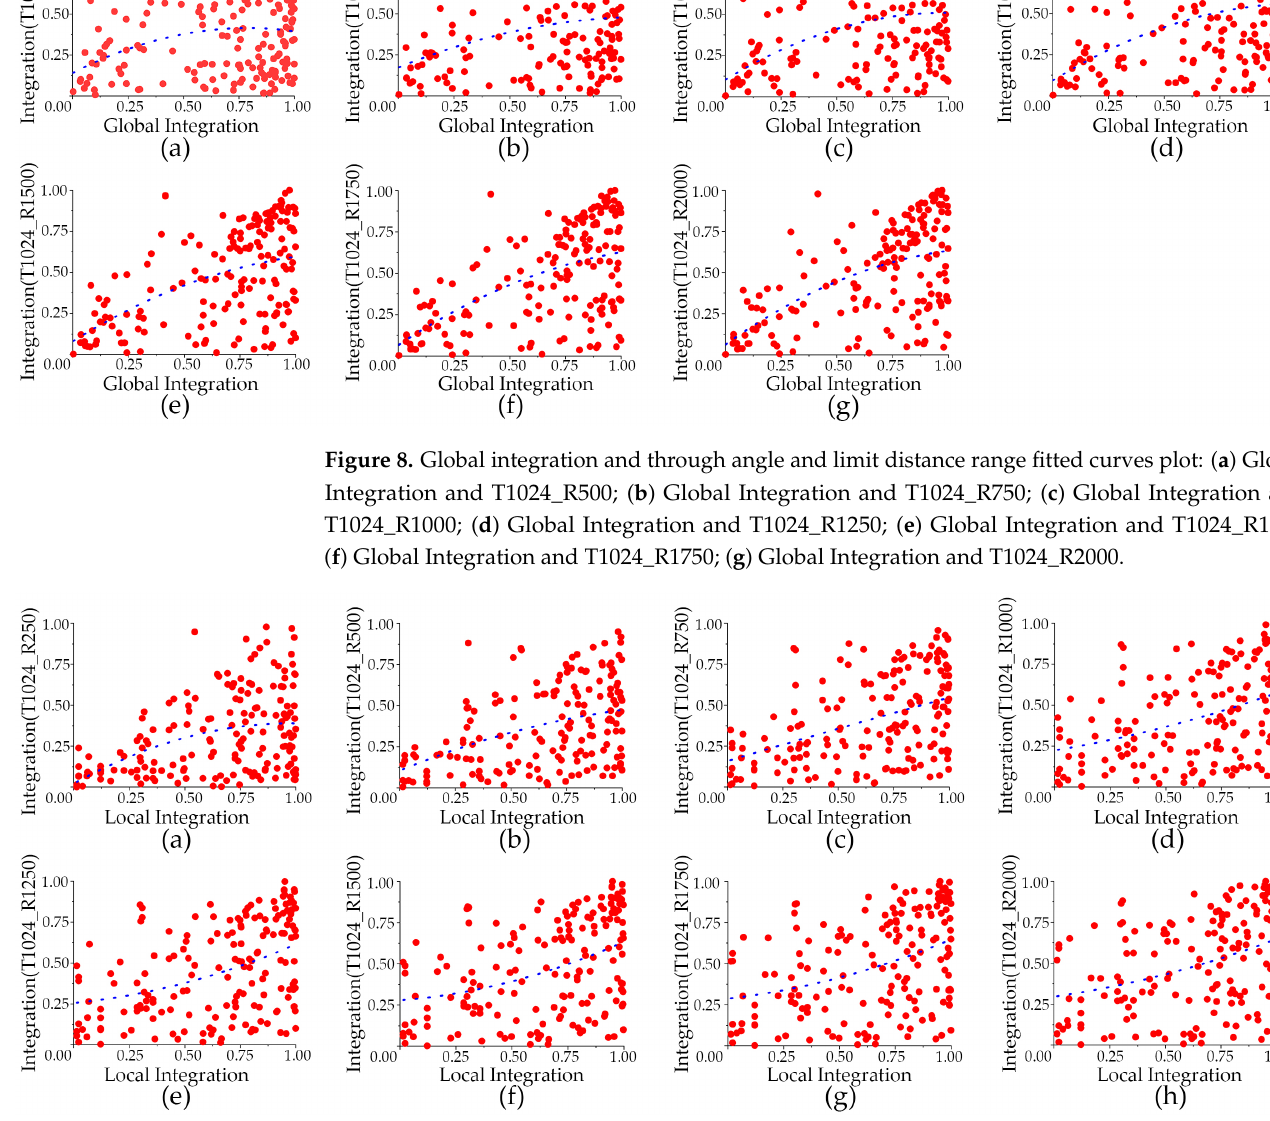
Figure 9. Local integration and through angle and limit distance range fitted curves plot: ( a ) Local Inte-